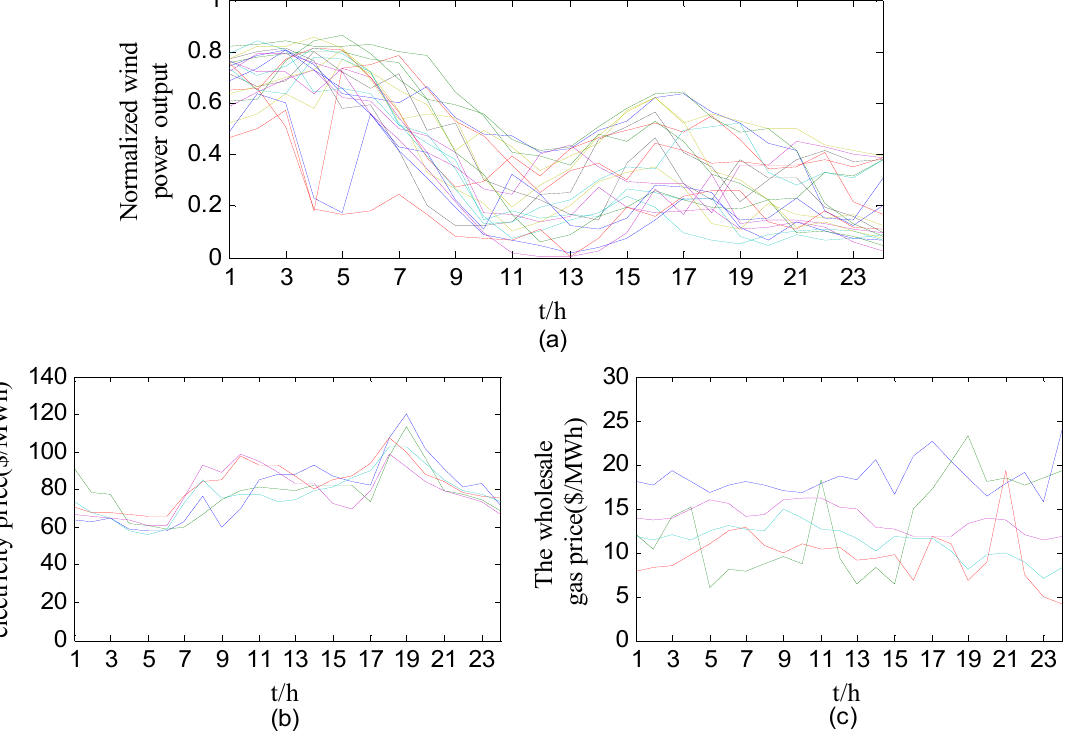
Figure 4. ( a ) Normalized wind power scenarios, ( b ) electricity price scenarios, ( c ) gas price scenarios.